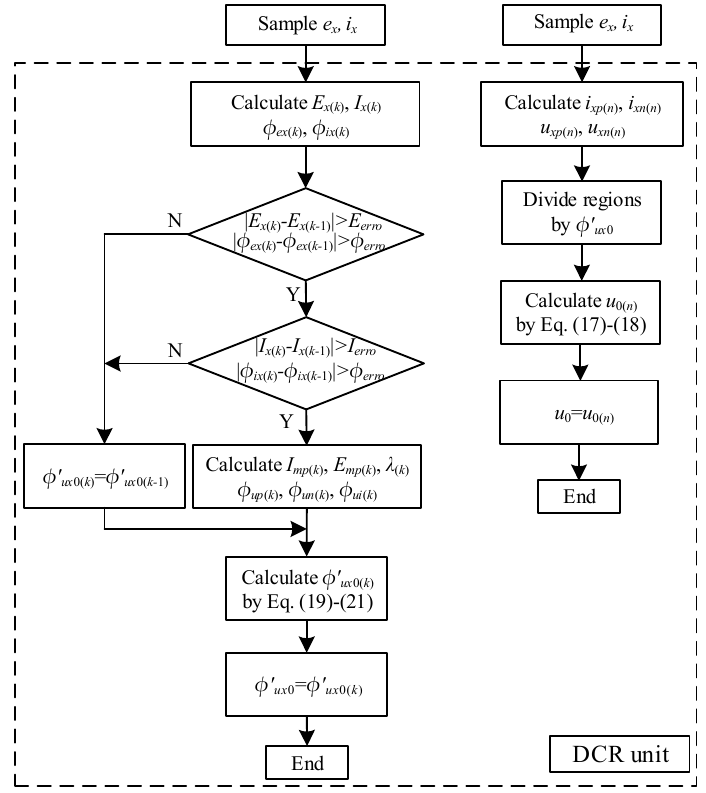
Figure 6. The flowchart of the DCR unit.